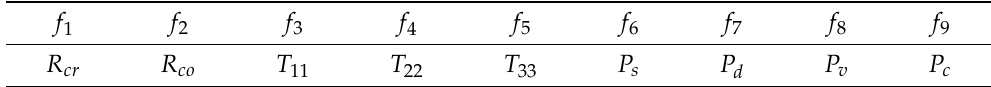
Table 11. The Polarimetric Feature Set II.